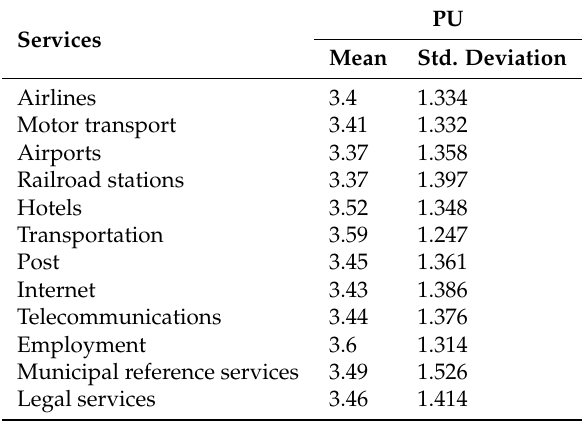
Table A13. Ranking for information about services by mean score of